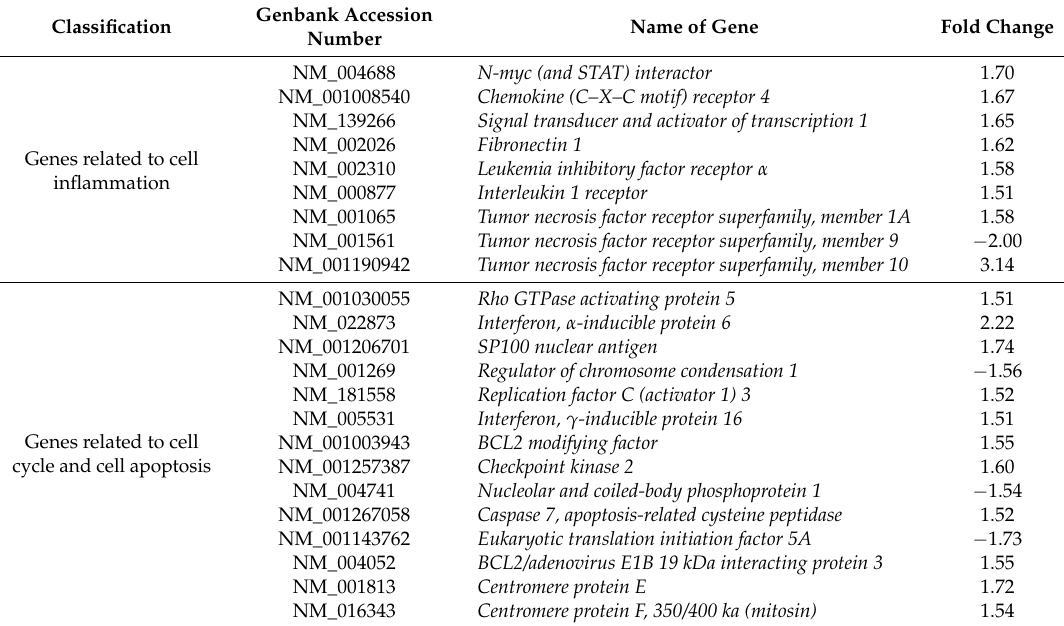
Table 1. Classification of α -tocopherol transfer protein ( α -TTP)-related genes.